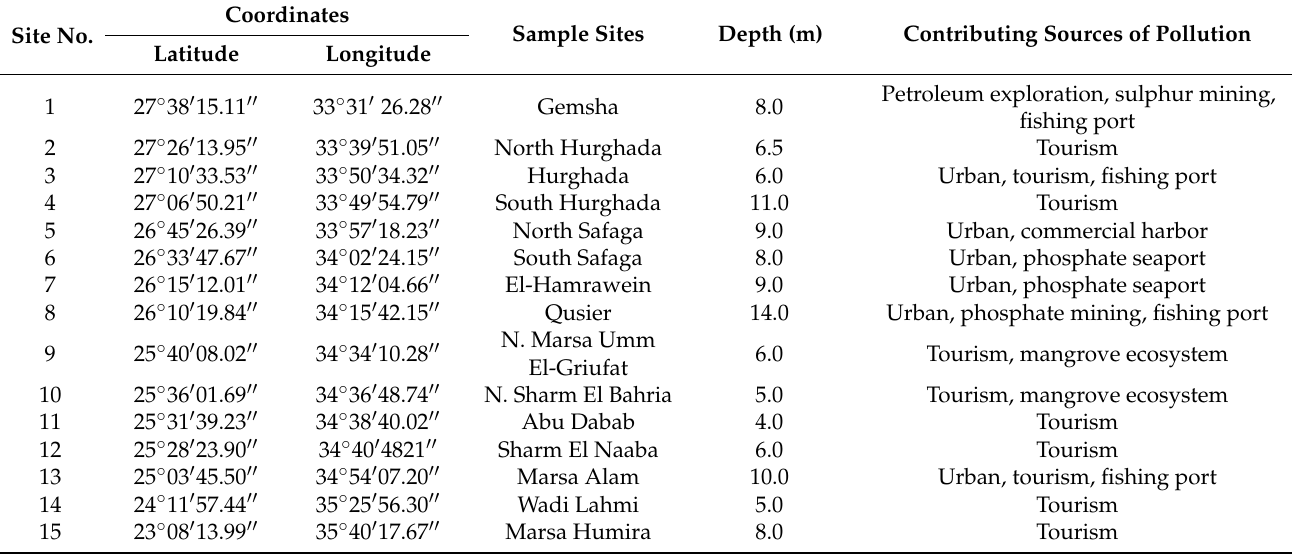
Table 1. Location and contributing sources of pollution of Red Sea sampling